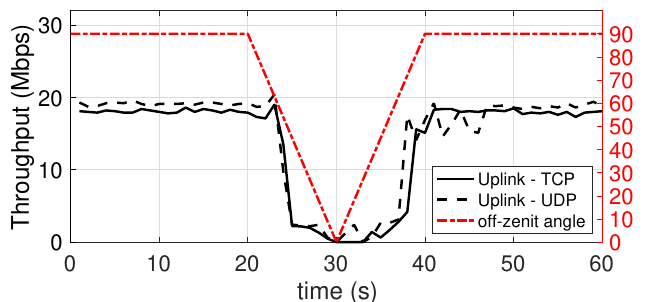
Figure 15. Uplink throughput with different orientation angle of the mobile device. TCP and UDP.